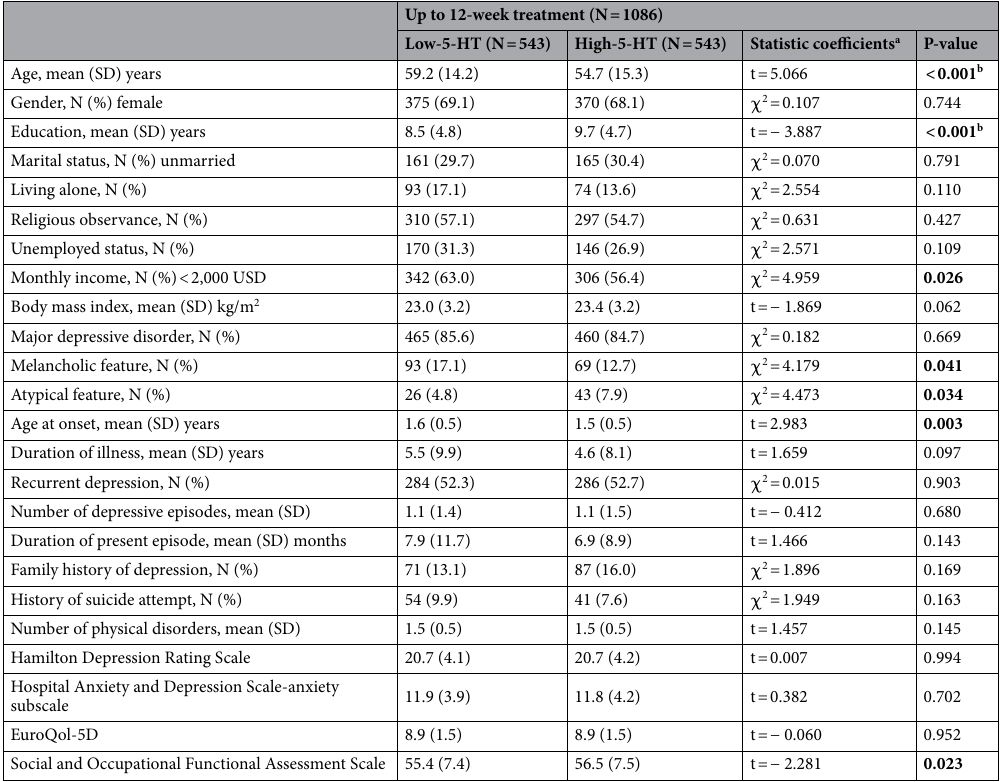
Table 1. Baseline characteristics based on serum serotonin levels in patients with depressive disorders. Significant values are in bold. a Independent two sample t -test or χ 2 test, as appropriate. b Values show statistical significance after Bonferroni correction.